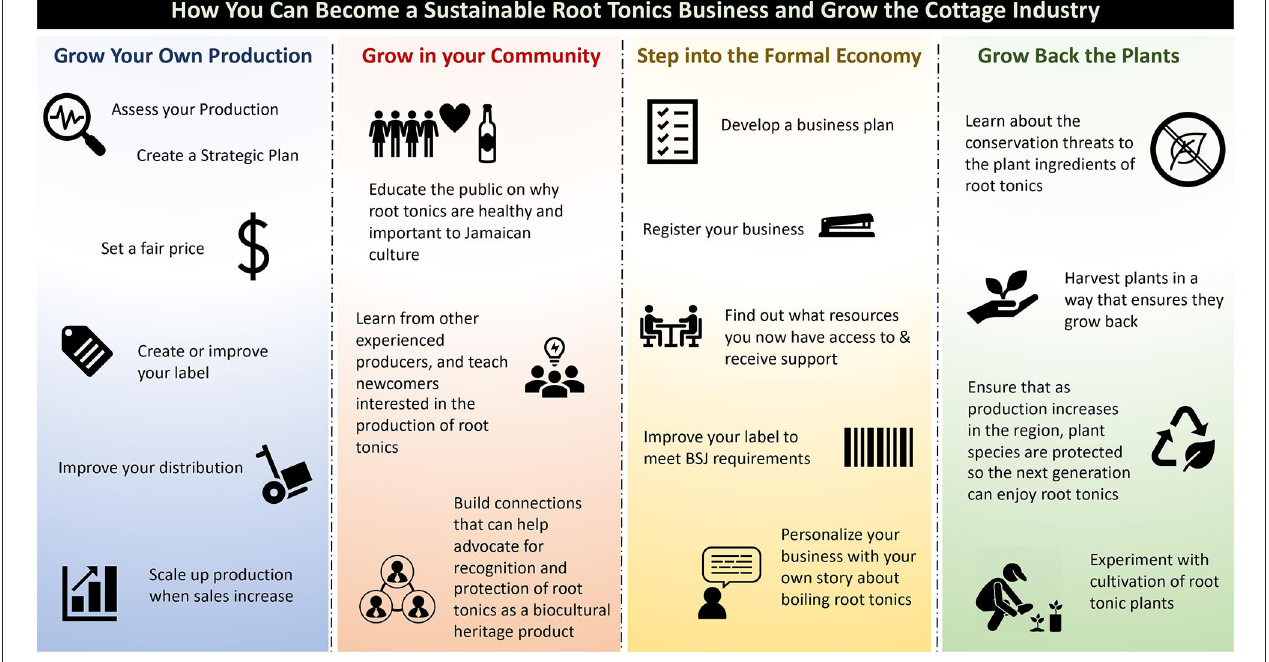
FIGURE 7 | Road map infographic for development of a sustainable root tonics cottage industry for artisanal producers. BSJ, Bureau of Standards